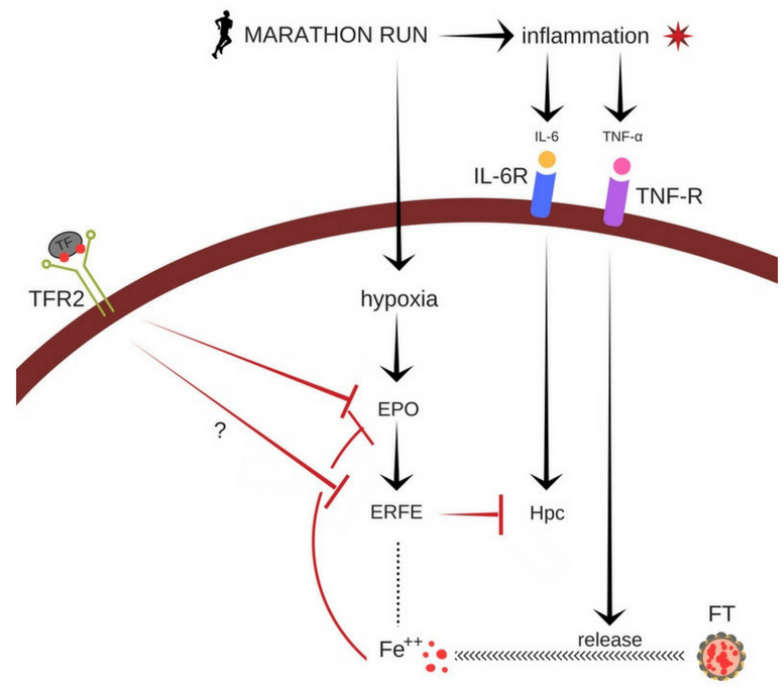
Figure 2. Summary of the potential e ff ects of a marathon running on cellular iron